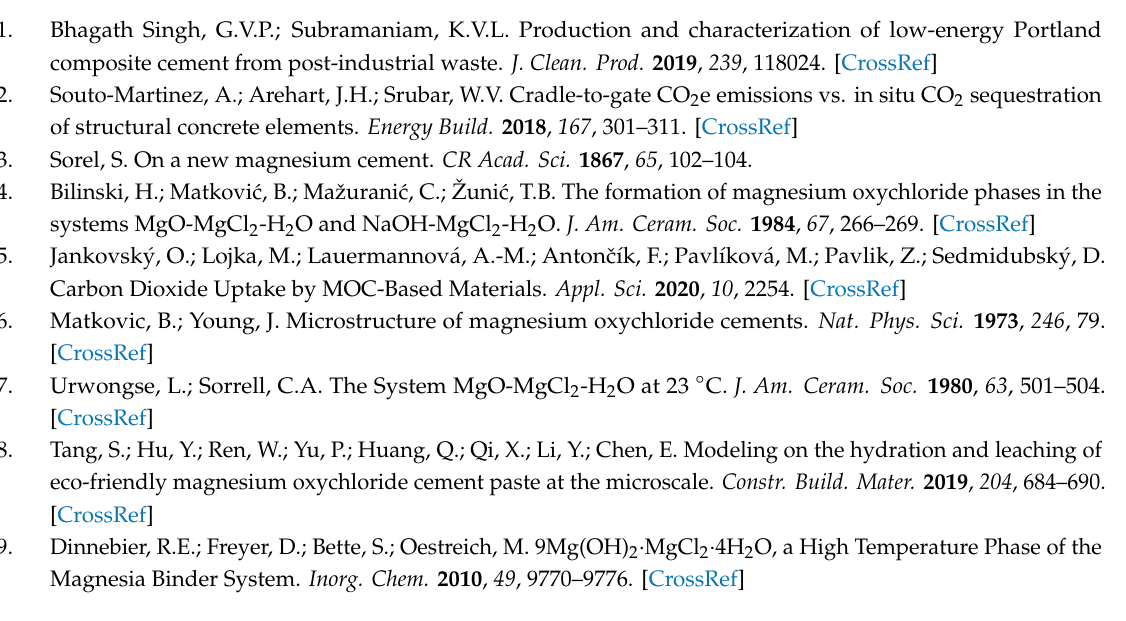
Figure S1: Di ff raction pattern of PW, Figure S2: SEM micrographs with di ff erent magnifications and EDS element maps of